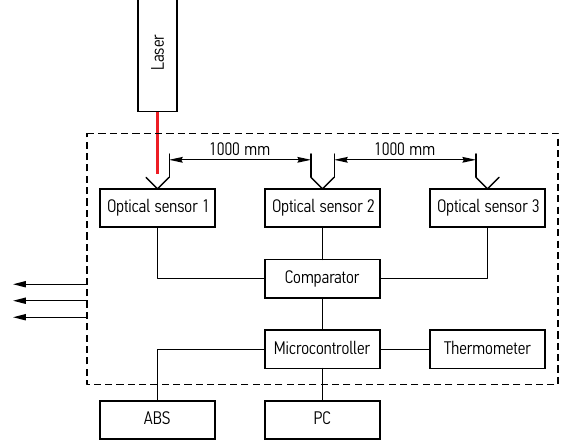
Fig. 3. System for precise velocity measurement with laser